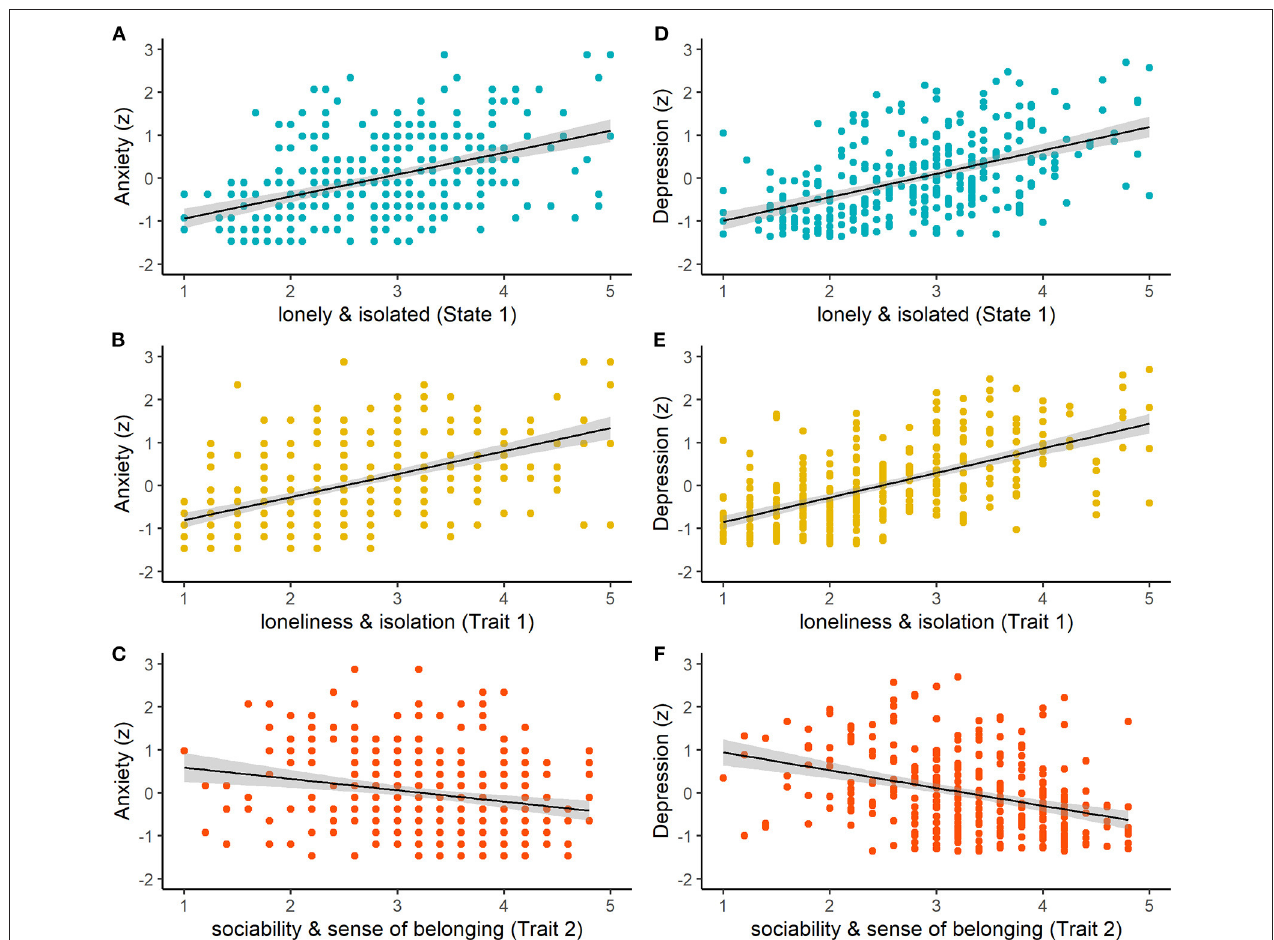
FIGURE 1 | Relationships between raw LISD factor scores and z-standardized scores of anxiety (left column) and depression (right column) for (A,D) lonely and isolated (State 1; p = 0.002, p < 0.001), (B,E) loneliness and isolation (Trait 1; p = 0.001, p = 0.020), and (C,F) sociability and sense of belonging (Trait 2; both p < 0.001). The shaded areas indicate standard errors of the